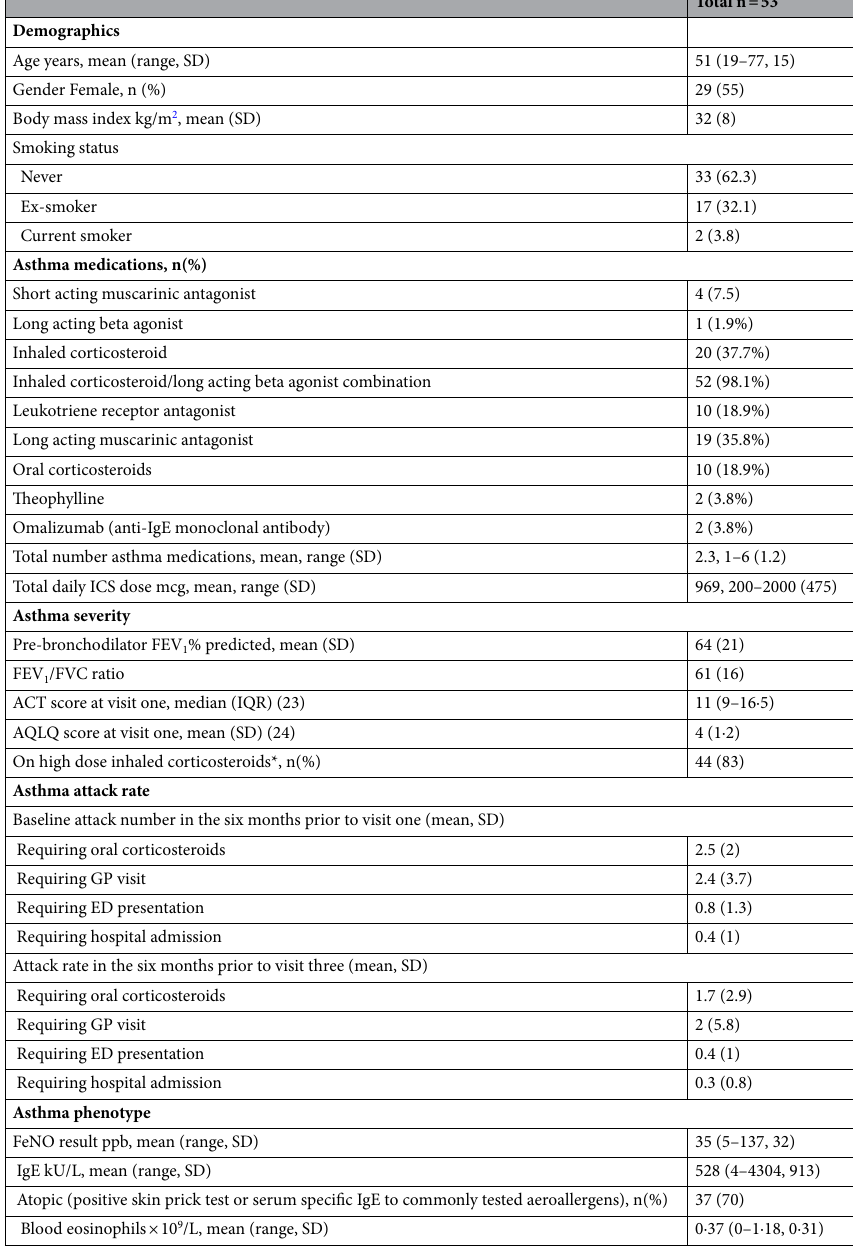
Table 1. Baseline patient characteristics. FEV 1 : Forced expiratory volume in one second, FVC forced vital capacity, ACT Asthma Control Test (scores range from 5 (poor asthma control) to 25 (complete